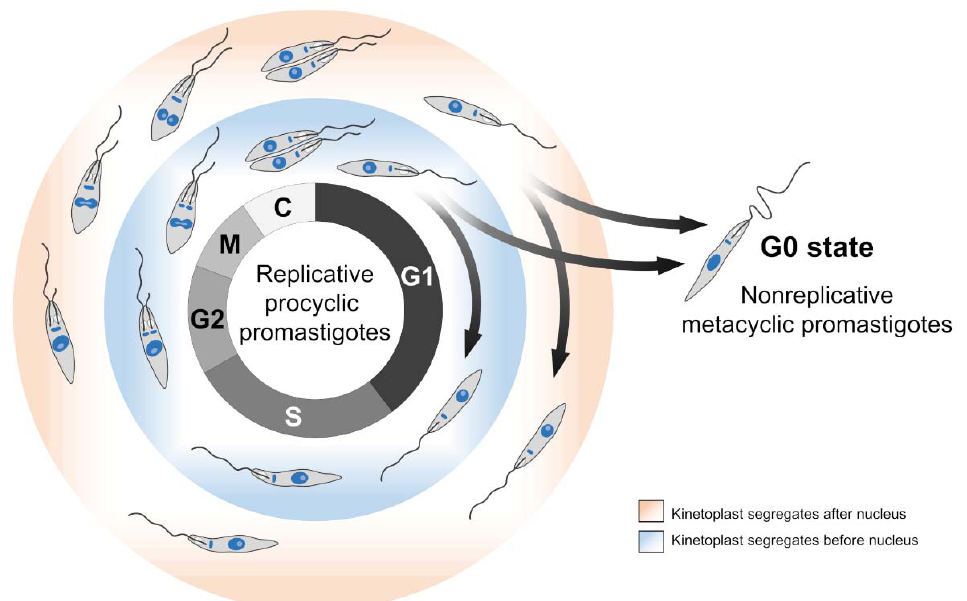
Figure 2. Scheme showing the two distinct patterns of kinetoplast segregation relative to the nucleus in promastigotes of Leishmania spp. throughout the cell cycle. Most Leishmania species presents one of the two kinetoplast segregation patterns presented: kinetoplast segregates after the nucleus (light red) or kinetoplast segregates before the nucleus (light blue). For instance, L. mexicana segregates its kinetoplast predominantly after the nucleus [37], while L. major and L. tarentolae do the opposite [38,39]. However, L. donovani and L. amazonensis exhibit these two patterns distributed in the population [40,41]. In Leishmania spp., as in most trypanosomatids, the G1 phase corresponds to the larger proportion of the cell cycle, while the other phases vary slightly in duration [42,43].